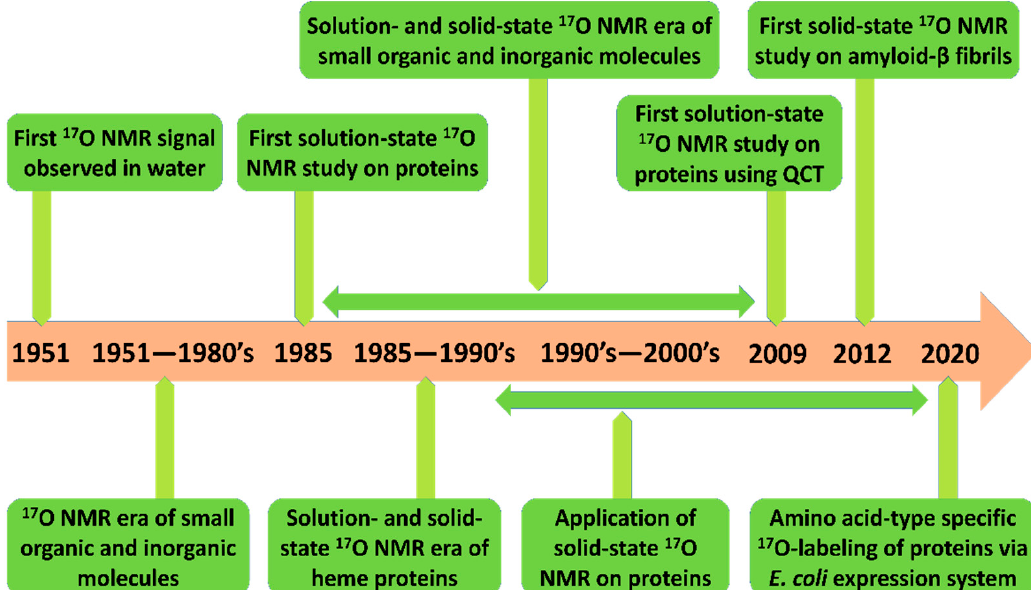
Figure 1. The timeline of notable developments in the field of 17 O nuclear magnetic resonance (NMR) spectroscopy for biomolecular investigations [15,17,20].